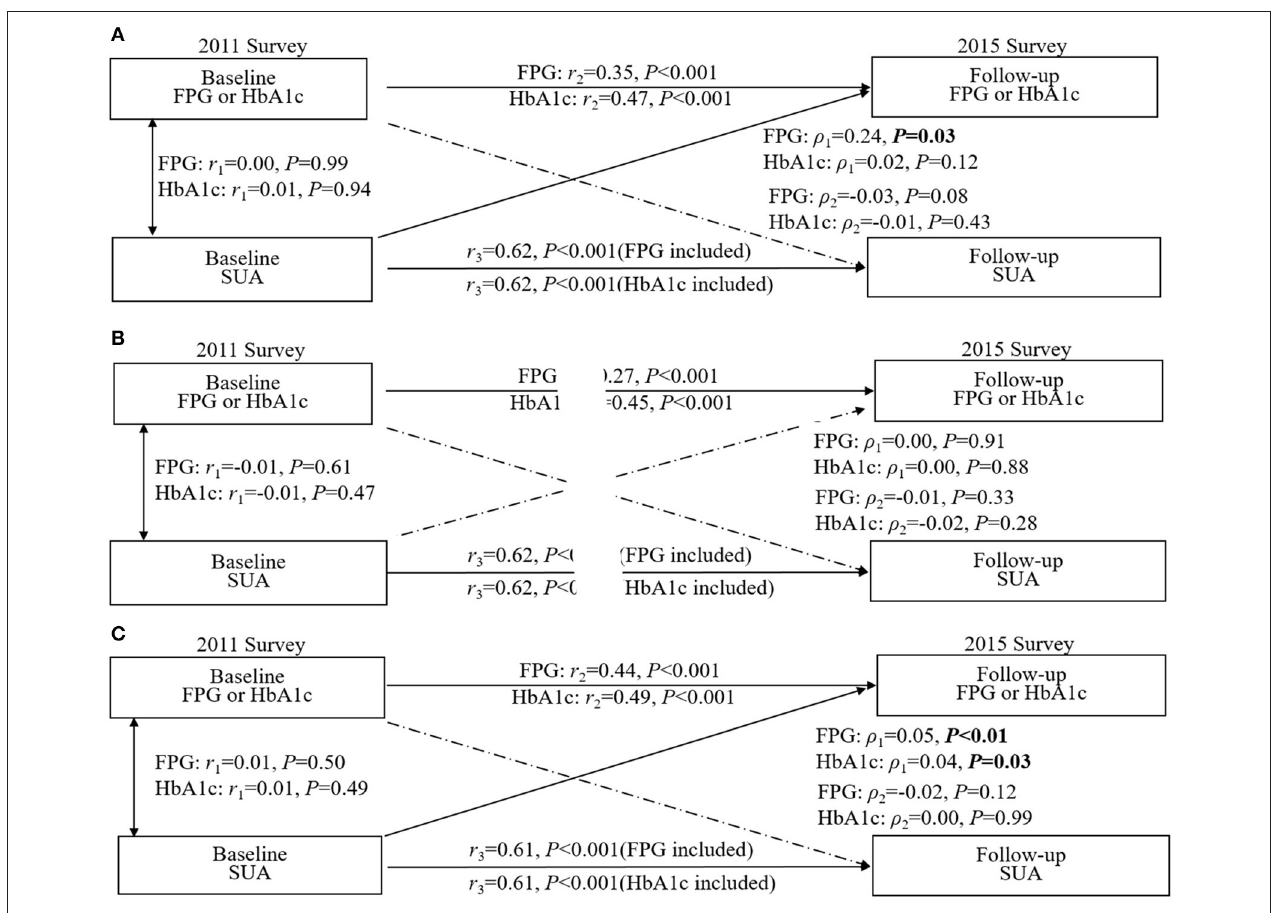
FIGURE 3 | Crosslagged path analysis models for the association of fasting plasma glucose (FPG) and HbA1c with SUA. (A) included all participants ( n = 6,873); (B) included male participants ( n = 3,162); (C) included female participants ( n = 3,711). All results were adjusted for age, sex, marital status, education background, waist circumference, smoking, drinking, hypertension and high-sensitivity C-reactive protein. ρ 1 , crosslagged path coefficient from baseline SUA to follow-up blood glucose (FPG and HbA1C); ρ 2 , crosslagged path coefficient from baseline blood glucose (FPG and HbA1C) to follow-up SUA. r 1 , represents synchronous correlations; r 2 and r 3 represent tracking